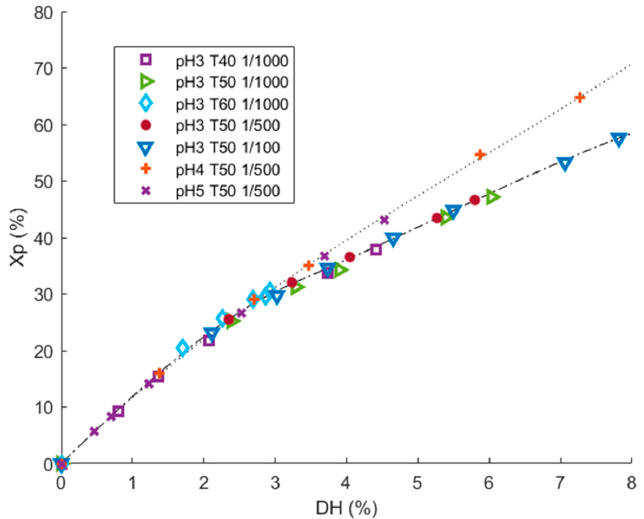
Figure 2. Identification of enzymatic mechanism for the hydrolysis of 1% ( w / v ) rapeseed proteins with Prolyve ® in the operating conditions area applied, during 5 h, by plotting the protein conversion rate ( Xp ) values versus degree of hydrolysis ( DH ) values.